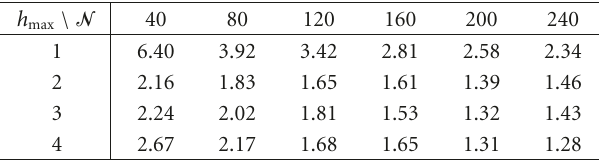
Table 3: Approximation error Δ as function of maximum row height h max and number of frames on a page N , expressed in [%].